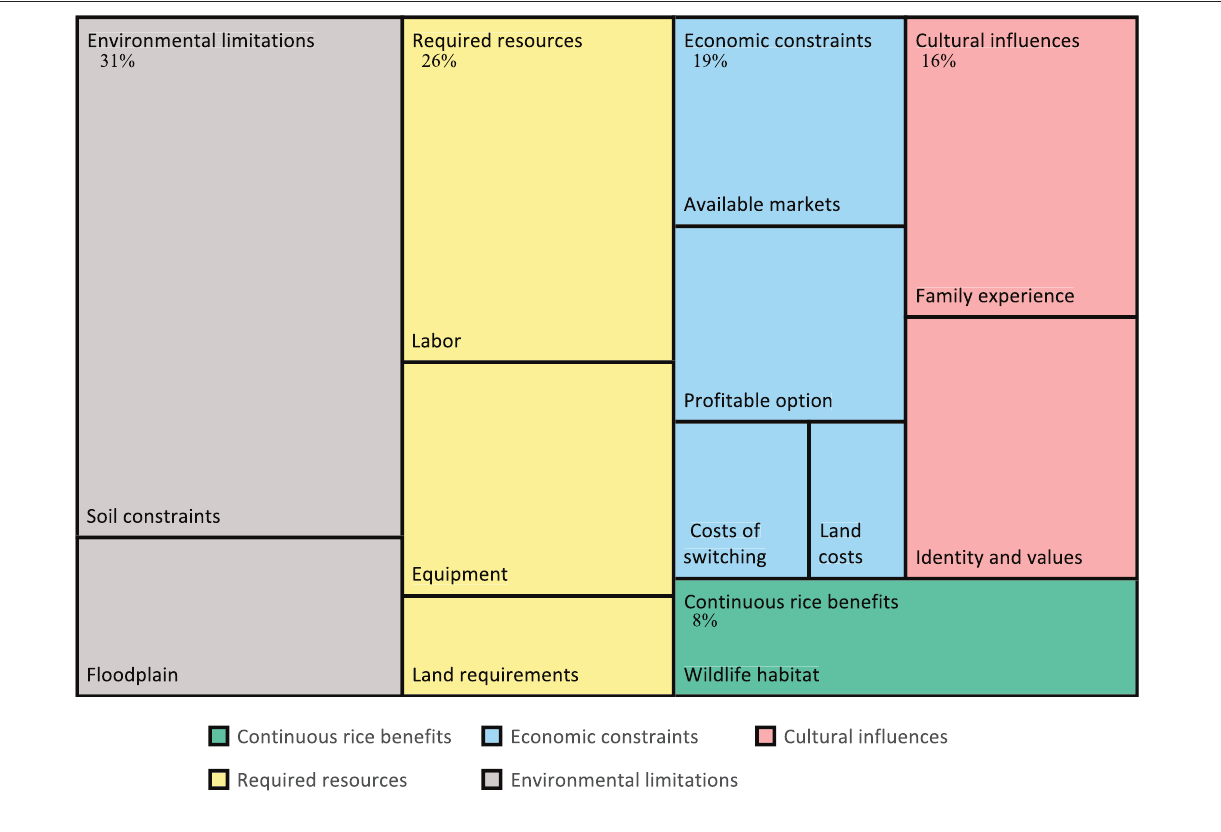
FIGURE 3 | Barriers to adoption for integrating crop rotations into rice systems. The size of each square is based on the number of references coded under each theme (indicated by%). The rank of most significant barriers was: environmental barriers (included soil limitations and the risk of farming on floodplains), economic barriers (included the lack of markets for other crops, lack of other profitable options they could grow, prohibitive operational costs (cost of switching) and overhead costs), resource barriers (included on-farm limitations such as not having the correct labor or management capacity, lacking correct equipment, and not having enough land), cultural barriers (included family experiences and grower identity/values), and continuous rice benefits (includes wildlife habitat which rotations may